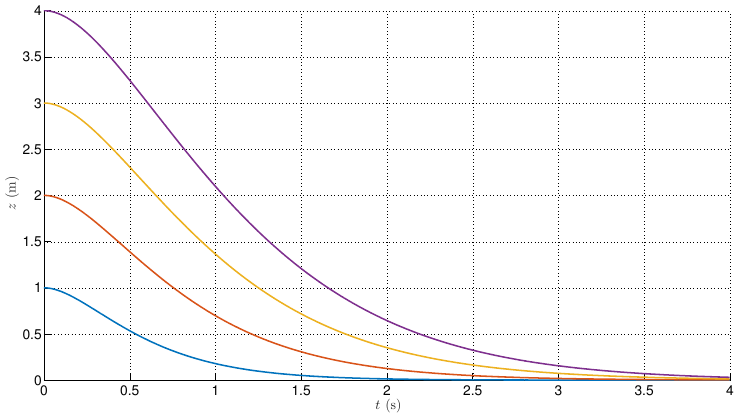
Figure 7. Velocity-penalized trajectories (for various initial altitudes—see the values at t = 0).